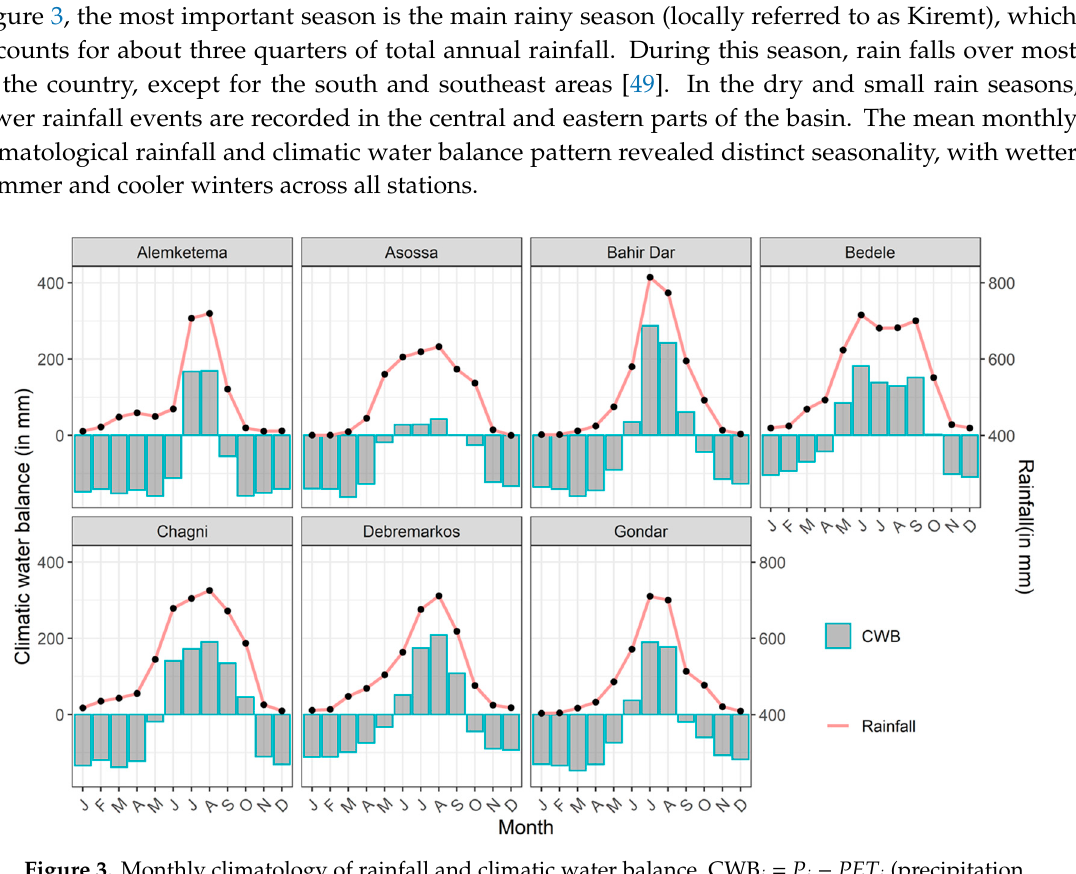
Table 1. Meteorological stations and their descriptive statistics.